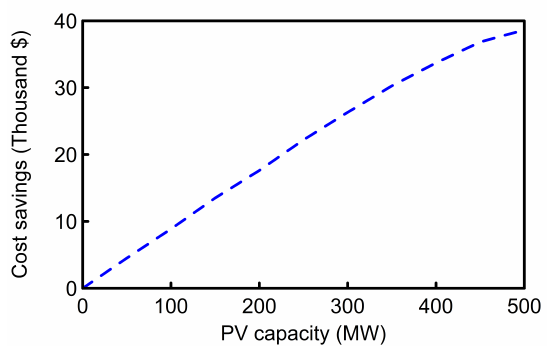
Figure 11. Operation cost saving due to increase in PV penetration. For the example day considered, an increase in operation cost was observed for PV penetrations below 500 MW due to operation of inefficient units to meet